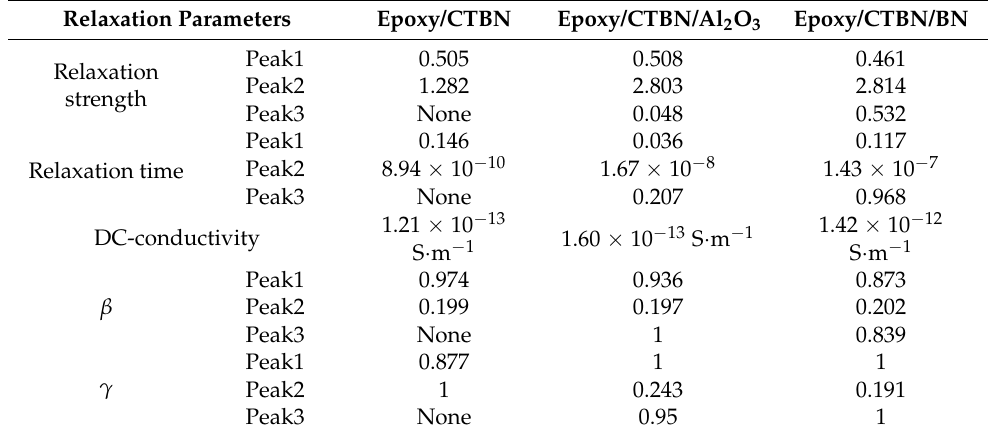
Figure 6. Peak-splitting results of the HN-equation of three kinds of samples at 25 ℃ . ( a ) Epoxy/CTBN; ( b ) Epoxy/CTBN/Al 2 O 3 ; ( c ) Epoxy/CTBN/BN. Table 2. Relaxation parameters fitted by the HN-equation of three kinds of samples at 25 ℃ .